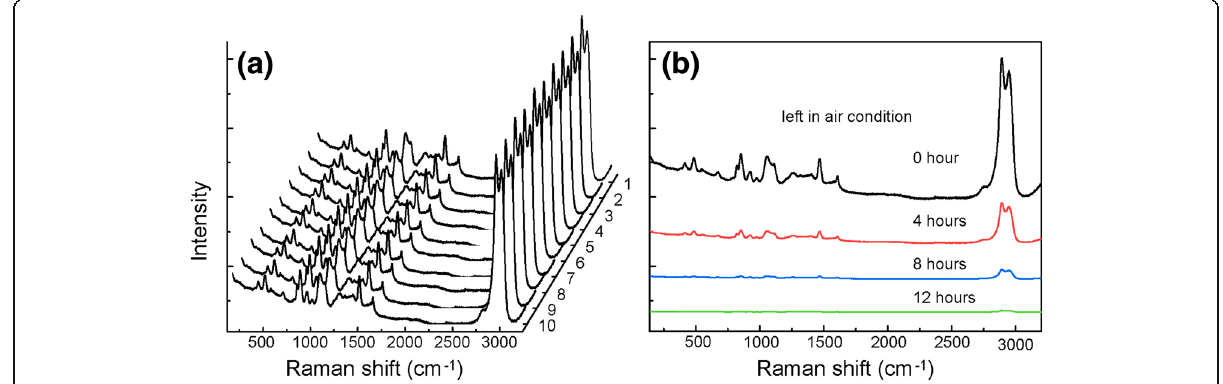
Fig. 5 The SERS spectra of glycerin collected from a 10 random points on the substrate as soon as well-prepared. b The same position on the substrate after different time left in air condition